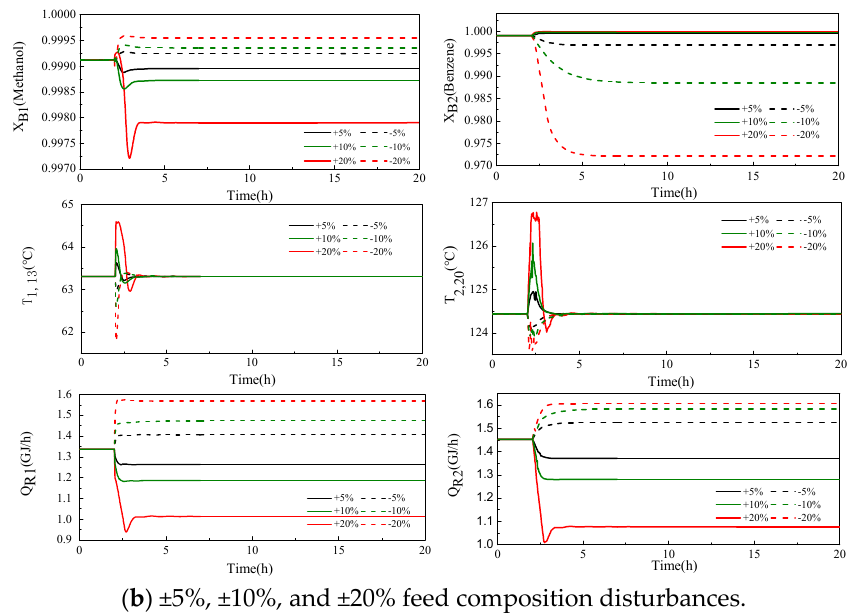
Figure 11. The dynamic responses of the basic control structure.